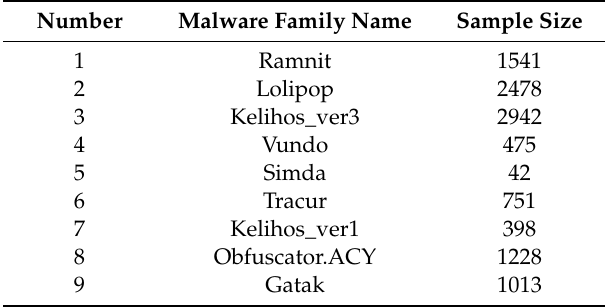
Table 2. The malware sample dataset